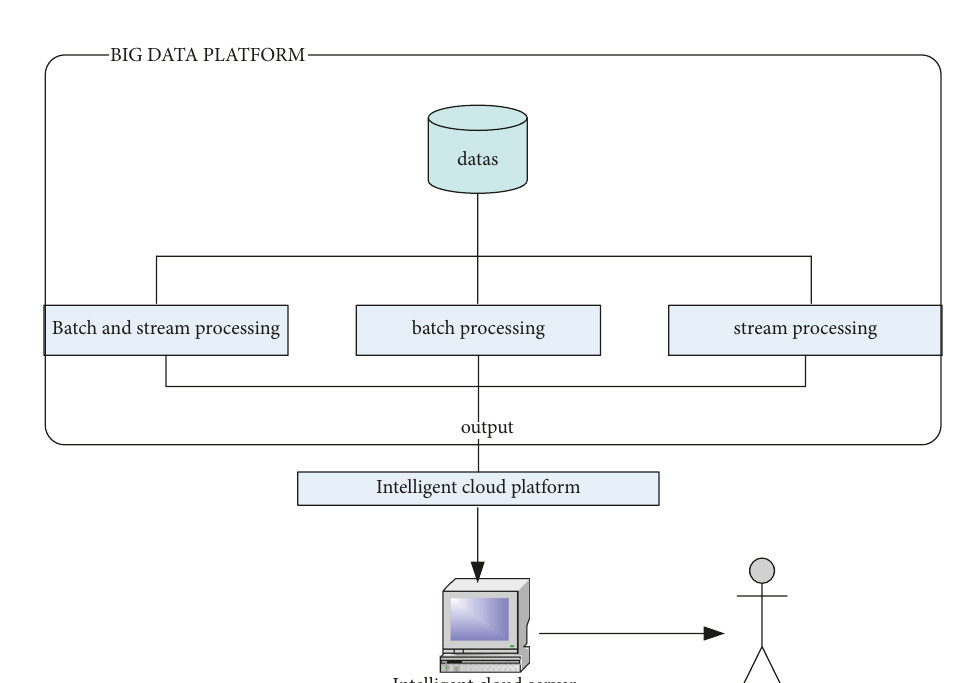
Figure 2: Data extraction flow chart.